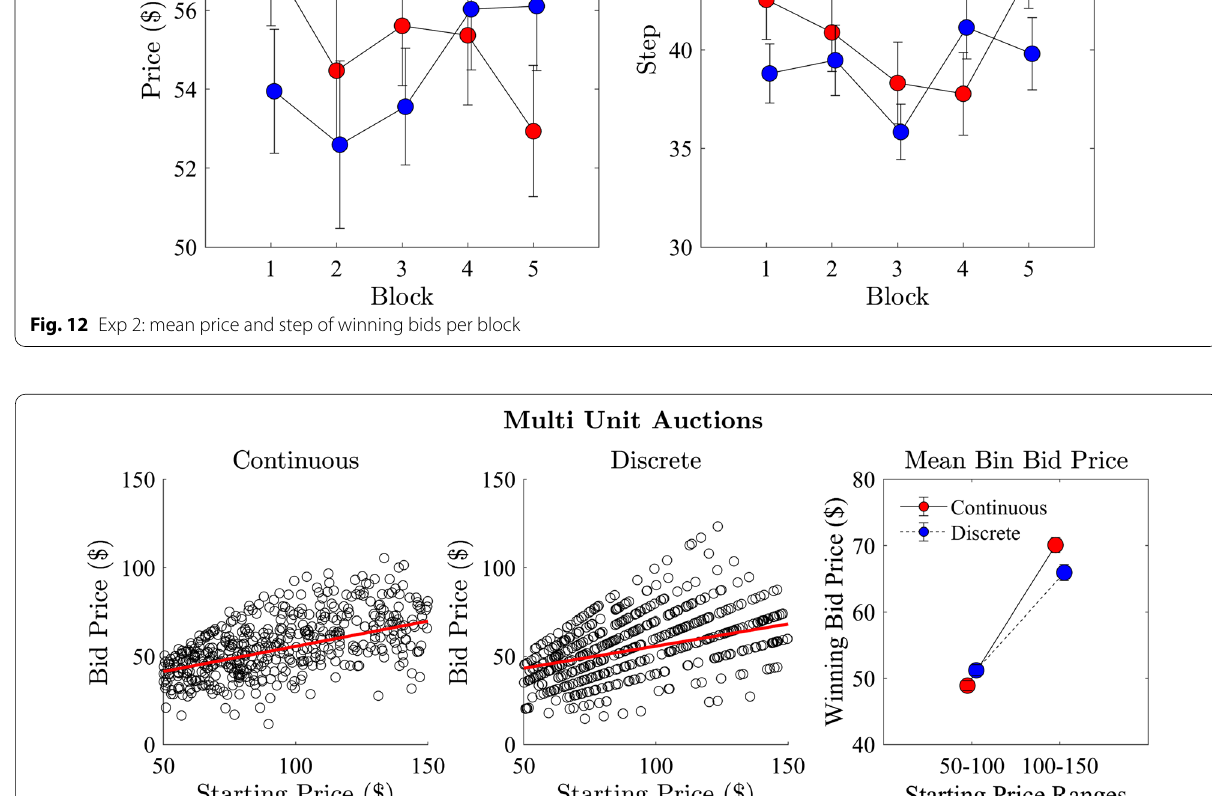
Fig. 13 Experiment 2. Relationship between auction starting price and the price of the winning bid in continuous (left) and discrete (middle) step conditions. The mean price of the winning bid for auctions was separated into low and high starting price (right) for both step